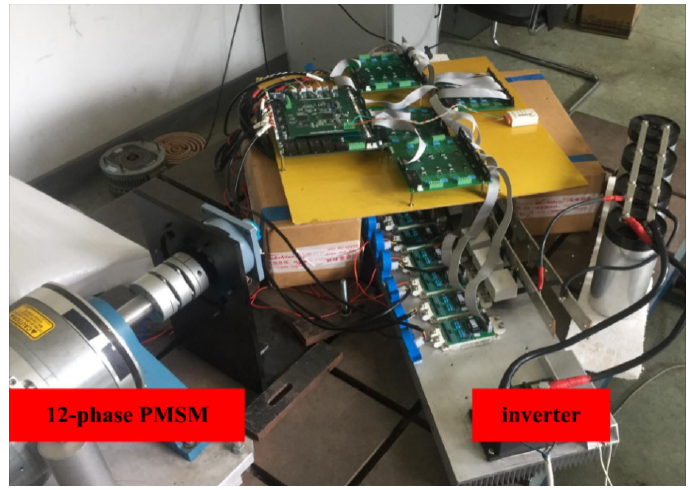
Figure 8 . Experiment’s system platform.